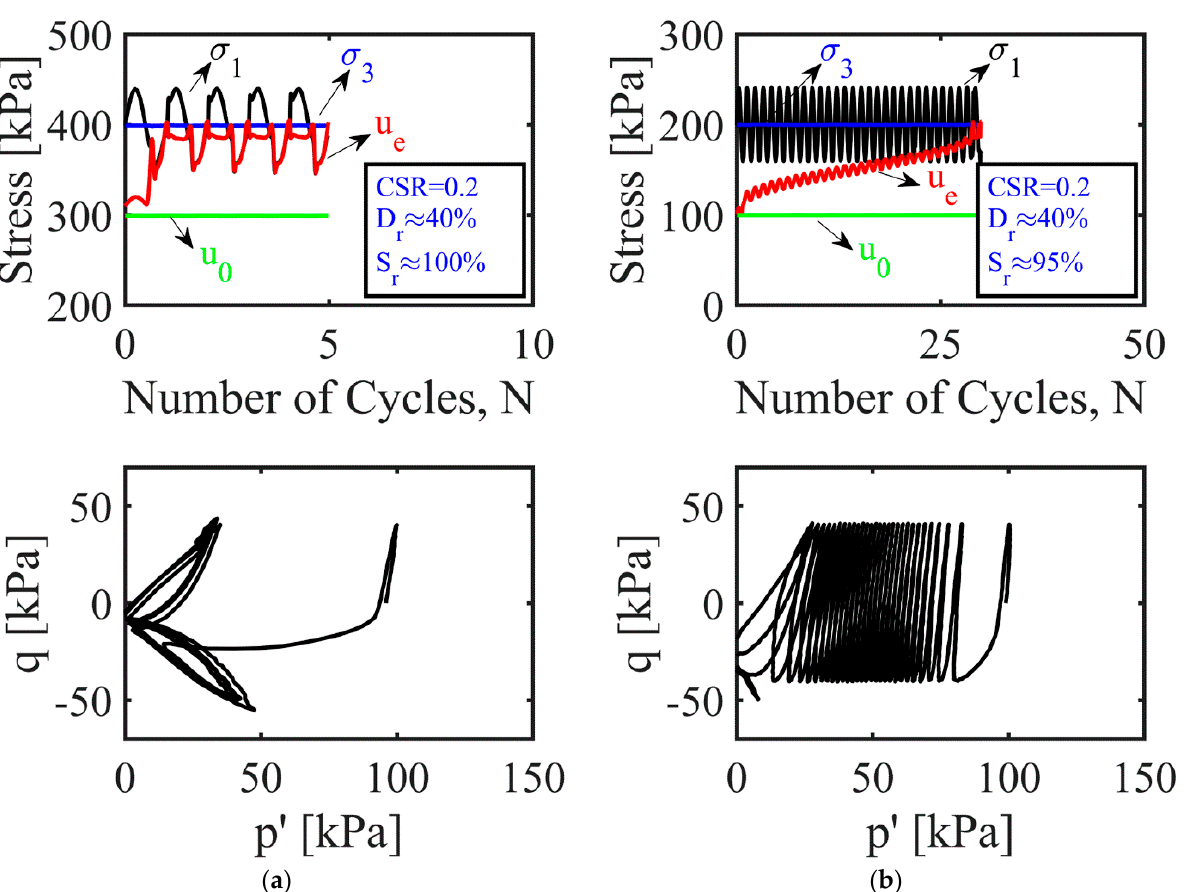
Figure 6. Typical test data for sand: ( a ) fully saturated sand; ( b ) partially saturated sand.